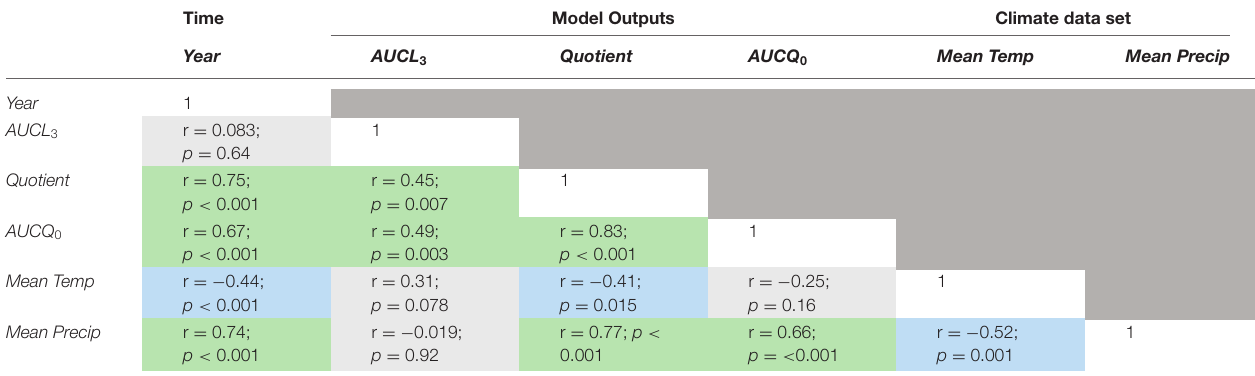
1st January and 365 = =